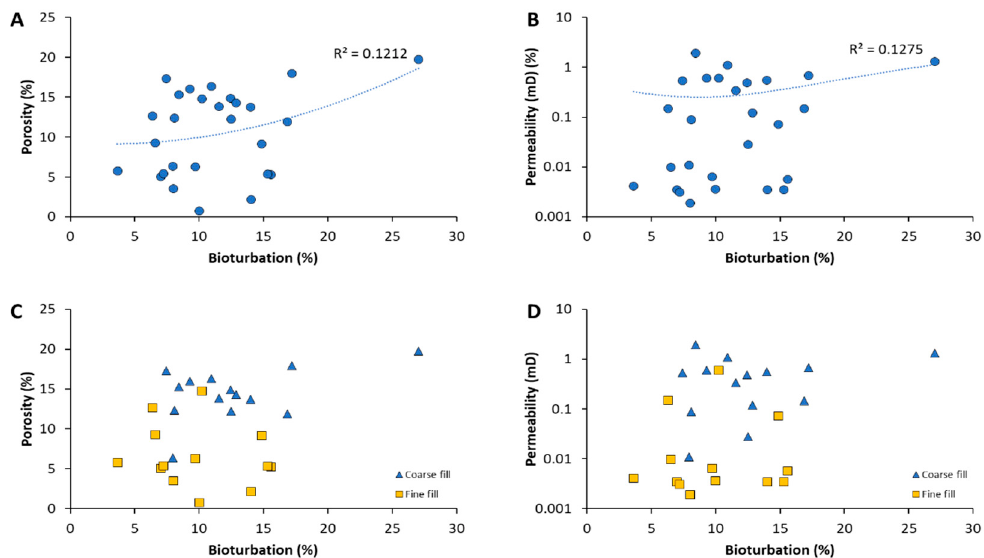
Figure 8. Bioturbation impact on porosity ( A ) and permeability ( B ) values, with weak relation between bioturbation and both porosity and permeability. ( C , D ) Burrow fill impact on porosity and permeability. Samples with coarse-filled burrows have higher porosity and permeability values.